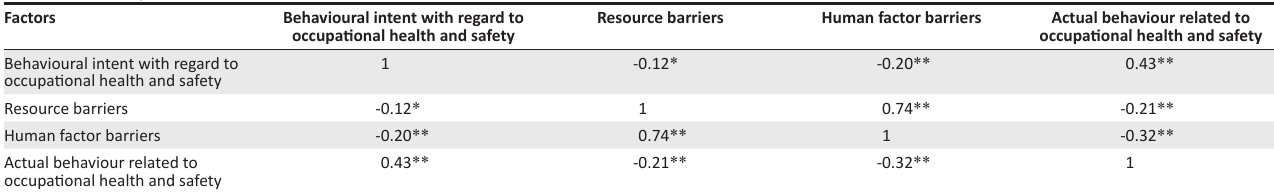
TABLE 6: Pearson product–moment correlation.